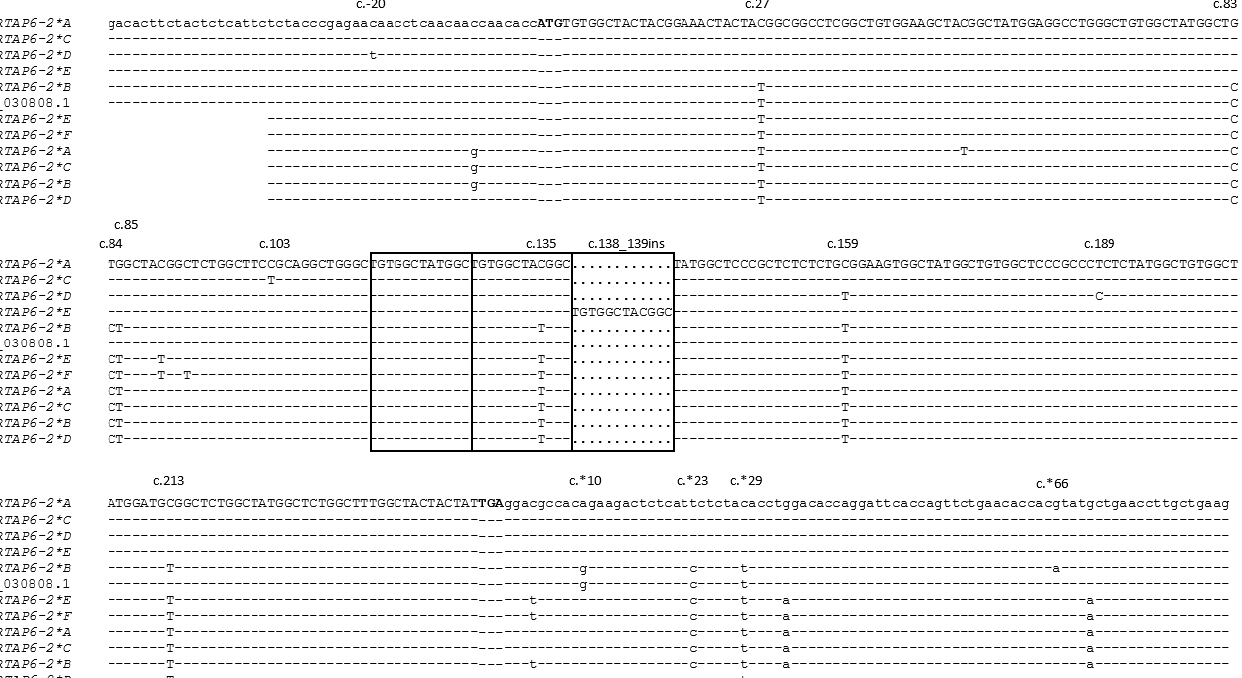
Figure 4. Alignment of the predicted amino acid sequences of the KRTAP6-2 and KRTAP6-5 variants identified in goats and sheep. Amino acids are represented in one letter code. Dashes represent amino acids identical to the top sequence and dots represent the absence of amino acids. The goat sequences are indicated with a prefix ‘g’, and the sheep sequences are with a prefix ‘s’. The GenBank accession numbers for sheep KRTAP6-2 ( A – F ) are KT725827–KT725832, and those for sheep KRTAP6-5 ( A – F ) are KT725841–KT725846. The GCGY repeats are shown in boxes.